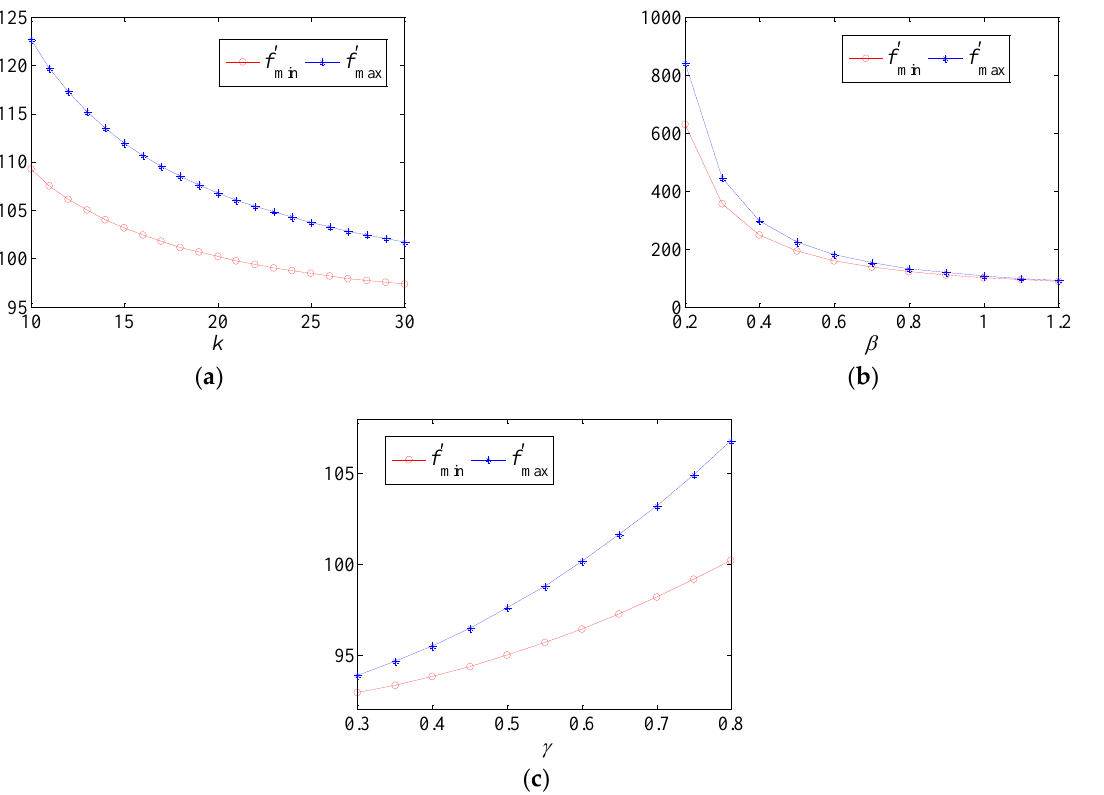
Figure 3. Effects of 𝑘 , 𝛽 , and 𝛾 on 𝑓 ′ . ( a ) Effect of 𝑘 on 𝑓 ′ . ( b ) Effect of 𝛽 on 𝑓 ′ . ( c ) Effect of 𝛾 on 𝑓 ′ .